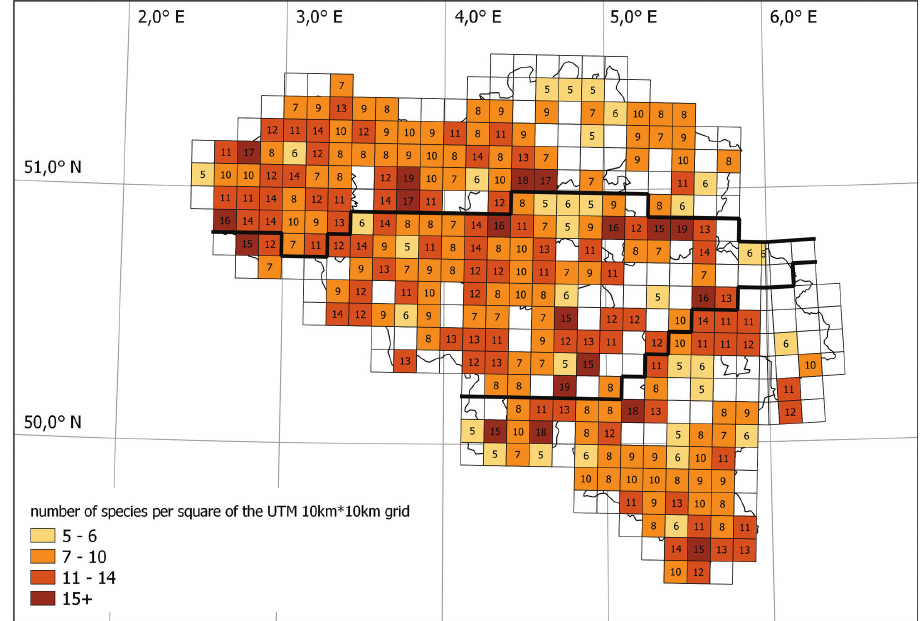
Figure 4. Map of Belgium with the number of species per square of the UTM 10×10 km